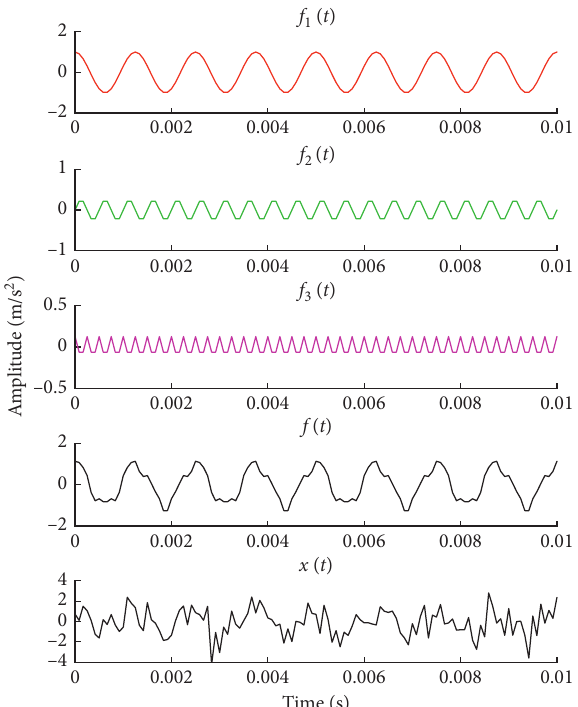
Figure 1: Time-domain waveform of f x ( t ) and f ( t ).